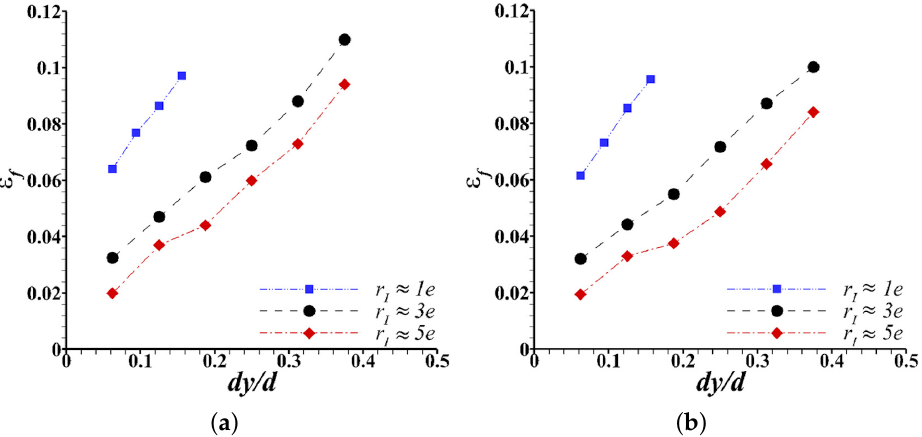
Figure 5. Effect of the size, r I , and location, dy / d , of an inclusion of strength ( a ) σ N = 300 MPa ( σ N / σ 0 ≈ 0.5) and ( b ) σ N = 800 MPa ( σ N / σ 0 ≈ 1.3) on the flexural strain to failure, ε f , (i.e. bendability) of a single-phase